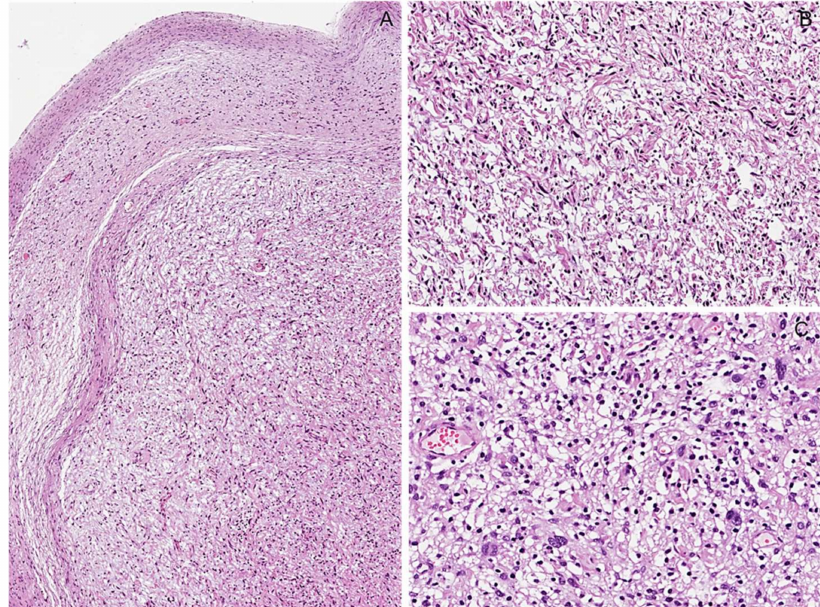
Figure 4. Nodular intraneural neurofibroma. ( A ) Intraneural nodule showing a well-circumscribed, unencapsulated proliferation of spindle cells. ( B ) The neoplastic proliferation is composed of inter- secting bundles of spindle cells with hyperchromatic wavy nuclei, sometimes with moderate nuclear atypia ( C